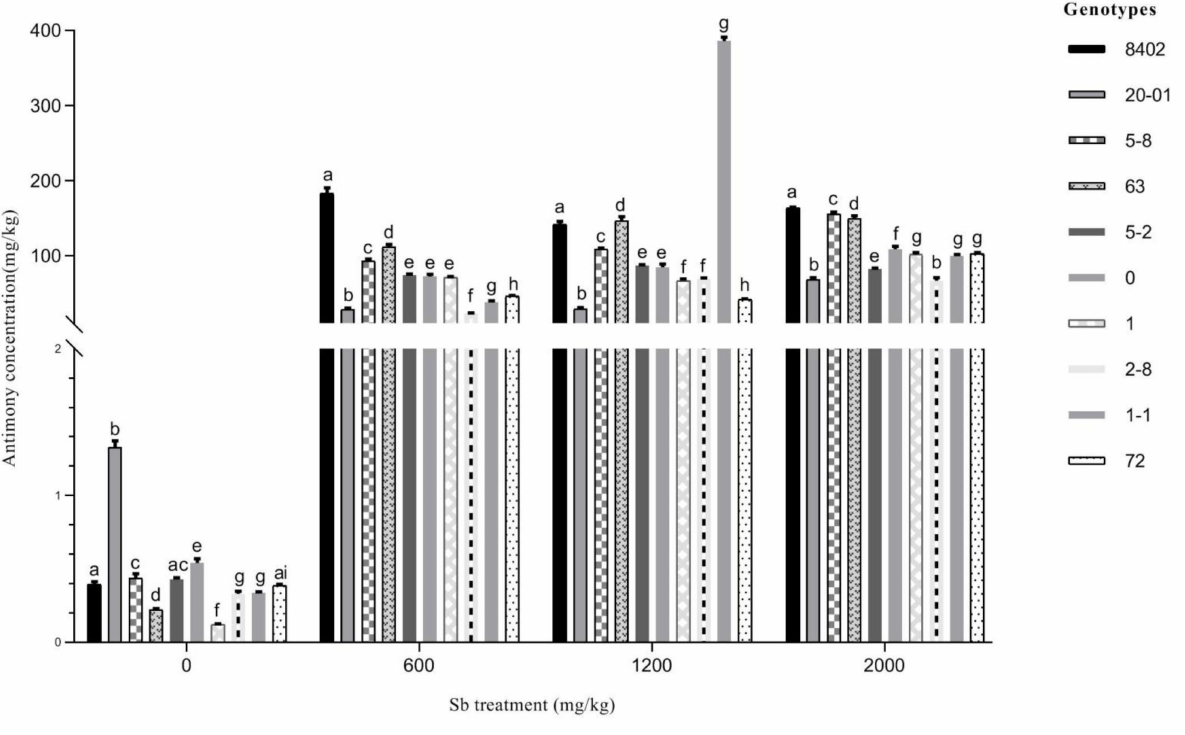
Figure 6. Sb concentrations in the stems of Catalpa bungei . Note: Different letters indicate significant differences among the treatments at p < 0.05 ( n =